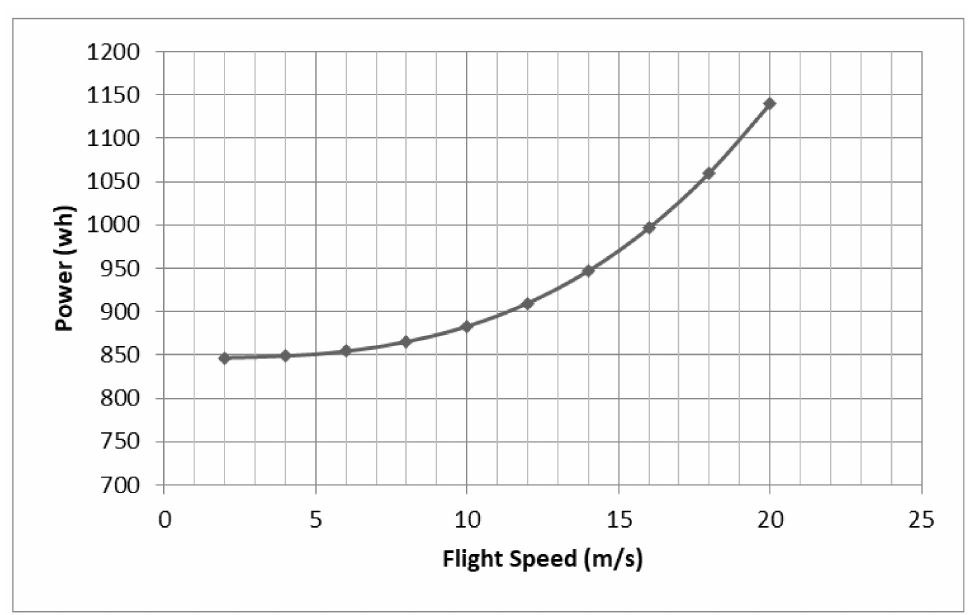
Figure 3. Overall power required by the drone as a function of the flying